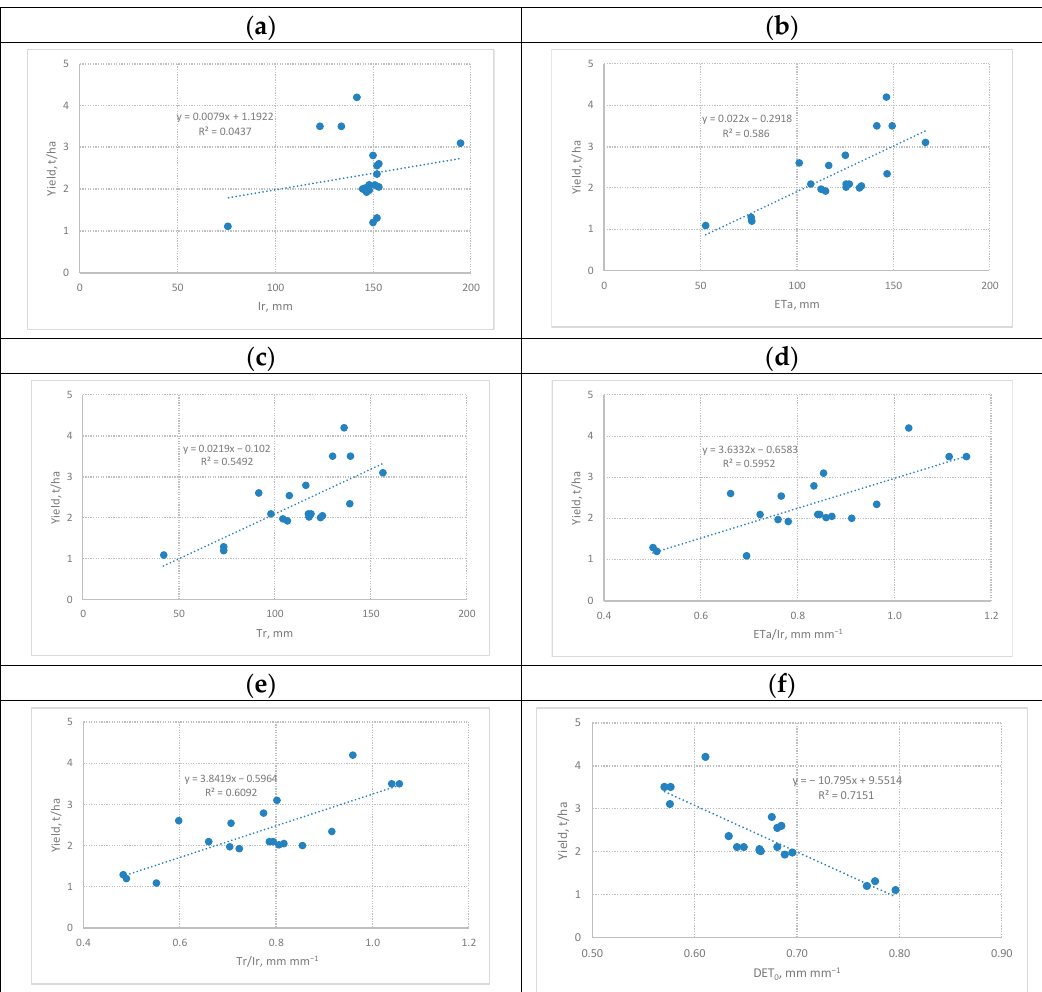
Figure 5. Points and lines showing the values of pares of two datasets and linear correlation functions of studied irrigated alfalfa crops during the period 05 May 2012–10 August 2012 for: ( a ) yield ( Y ) as function of irrigation depth Ir; ( b ) yield ( Y ) as function of evapotranspiration ( ETa ); ( c ) yield ( Y ) as function of transpiration ( Tr ); ( d ) yield ( Y ) as a function evapotranspiration and Irrigation rate ( ETa/Ir ); ( e ) yield ( Y ) as a function transpiration and Irrigation rate (Tr/Ir); ( f ) yield (Y) as a function average deficit of basal evapotranspiration ( dETo ).